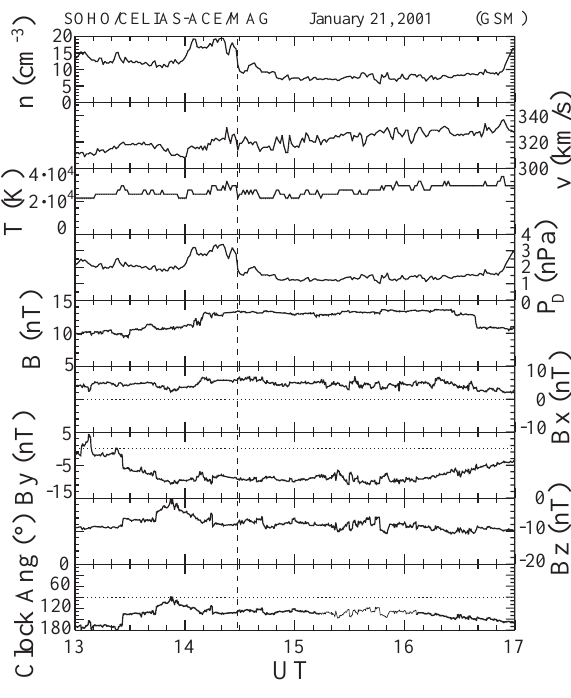
Fig. 7. Ionospheric footpoints of FAST (red) and Cluster (blue) relative to Søndrestrøm. (blue) and FAST (red) spacecraft. A magnetic conjunction occurs where the trajectories cross at about 15:45 UT, which is near the time when the dynamic pressure drop arrives at the magnetopause. The conjunction maps to near the location of the Søndrestrøm radar (green dot). At the time of con- junction Søndrestrøm was at about 13:00 MLT at the open- closed field line boundary ( Farrugia et al., 2004a). The radar at Søndrestrøm observed a transient flow channel around the time of conjunction, with strong ∼ 2 km/s antisunward flow just poleward of the convection reversal (see Farrugia et al., 2004a, Fig. 13). Since the IMF B y is negative here, in